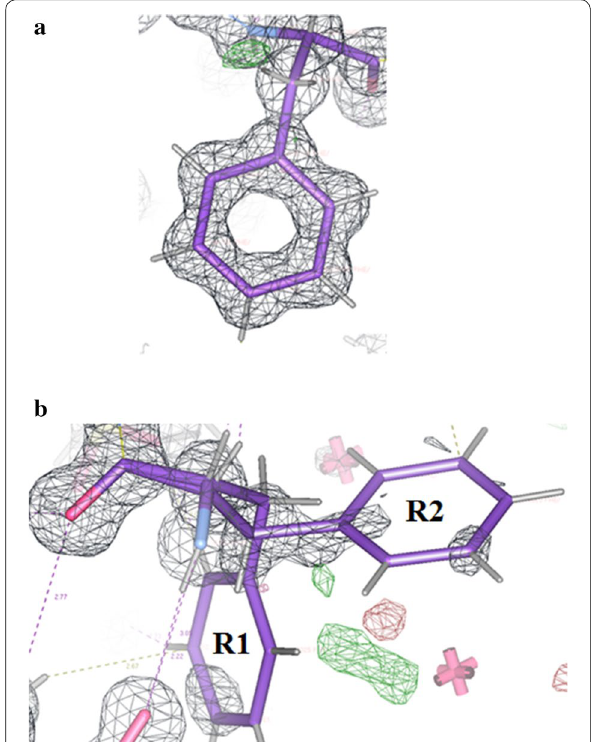
Fig. 27 a Electron density in the Insugen (I) structure for PheB24, an example of a clear single highly resolved amino acid residue. b Electron density in the Insugen (I) structure for PheB25, an example of very poor density modelled as a doubly disordered acid residue. This result is surprising in view of the high order observed in PheB24 ( a